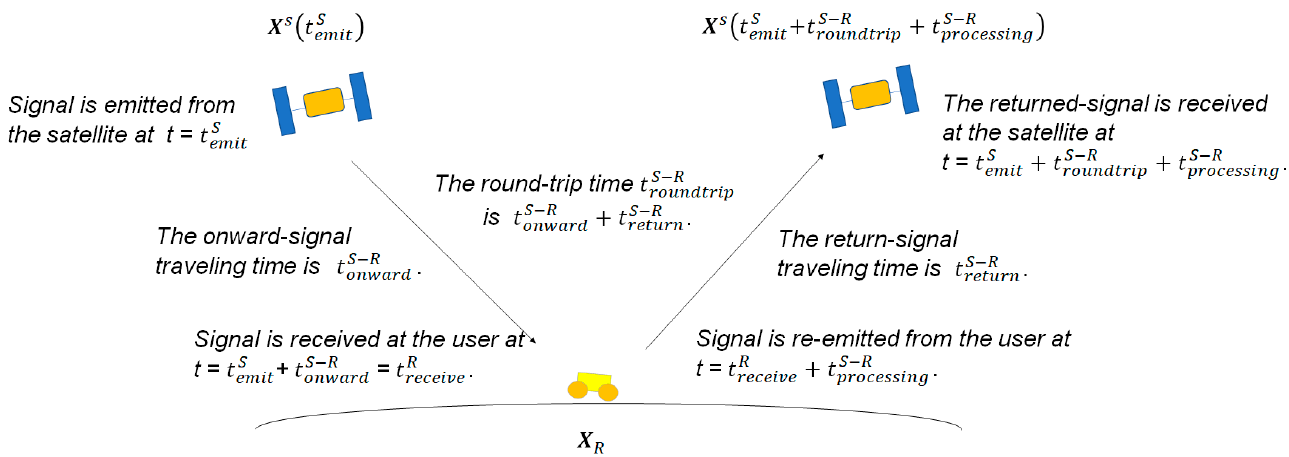
Figure 3. Two-way ranging.